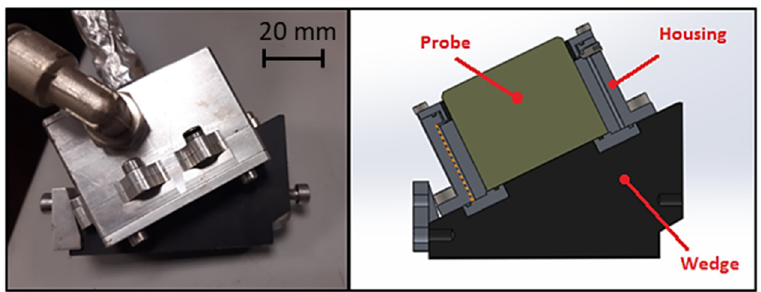
Figure 5. US Probe and wedge assembly.